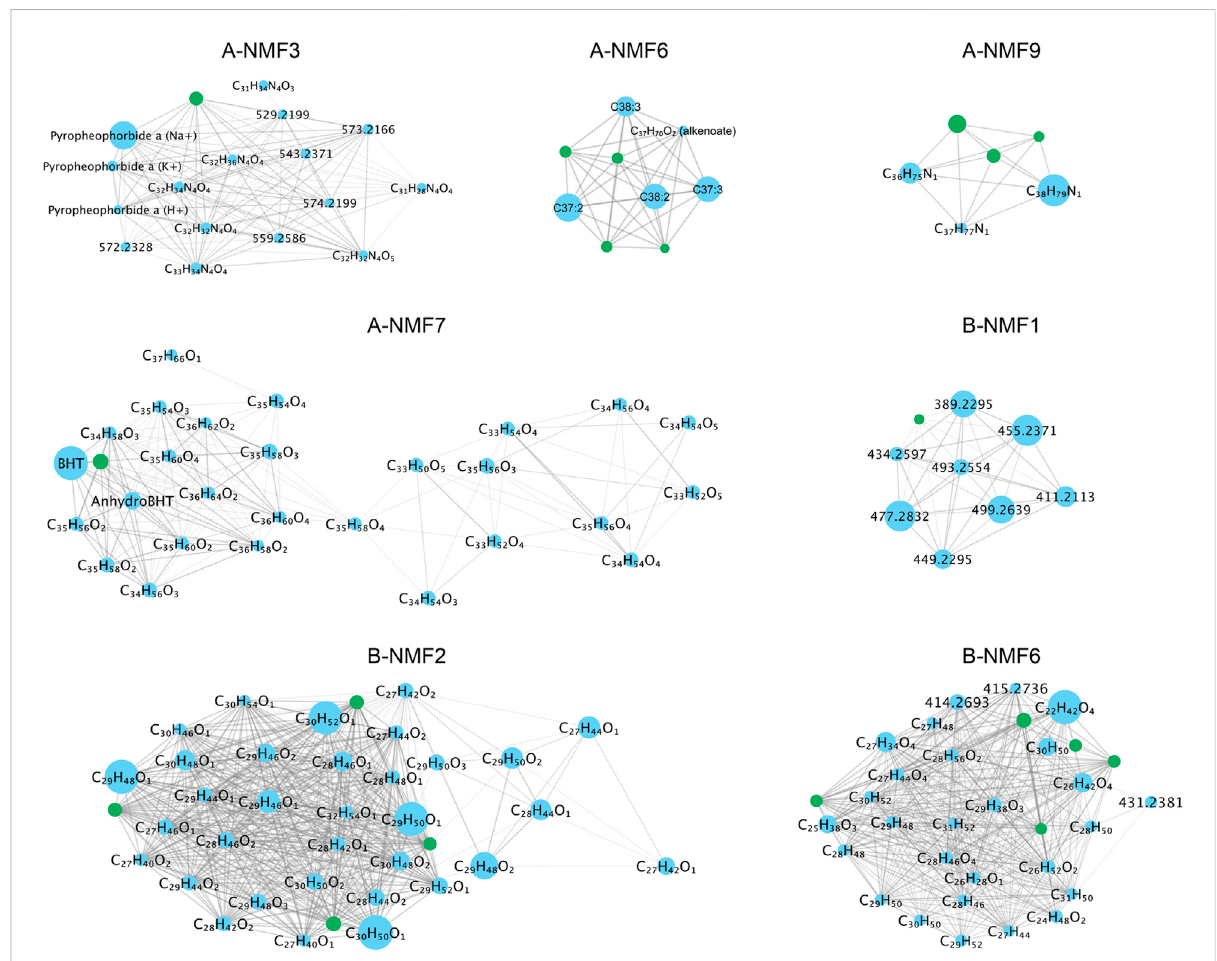
FIGURE 4 Examples of spatially co-occurring molecular networks discovered in datasets (A) and (B). Each node represents a molecule, with the labels beingthenameofbiomarkers,possiblechemicalformulas,orits m/z ratios.Thesizeofthenodedenotestheaverageintensityofthemoleculeinthe dataset.Isotopologuesarerepresentedbythegreennodes.Edges(linesbetweenthenodes)denotethatthetwoconnectednodesareclassi fi edinto thesameclusterforatleast90%oftotalNMFruns,andthickeredgesdenotethetwoconnectednodesareclustered